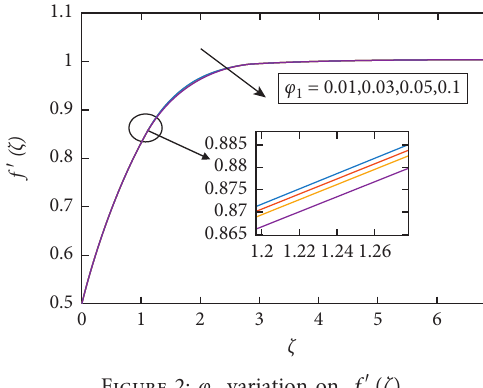
variation on f ′ ( ζ ) . 1